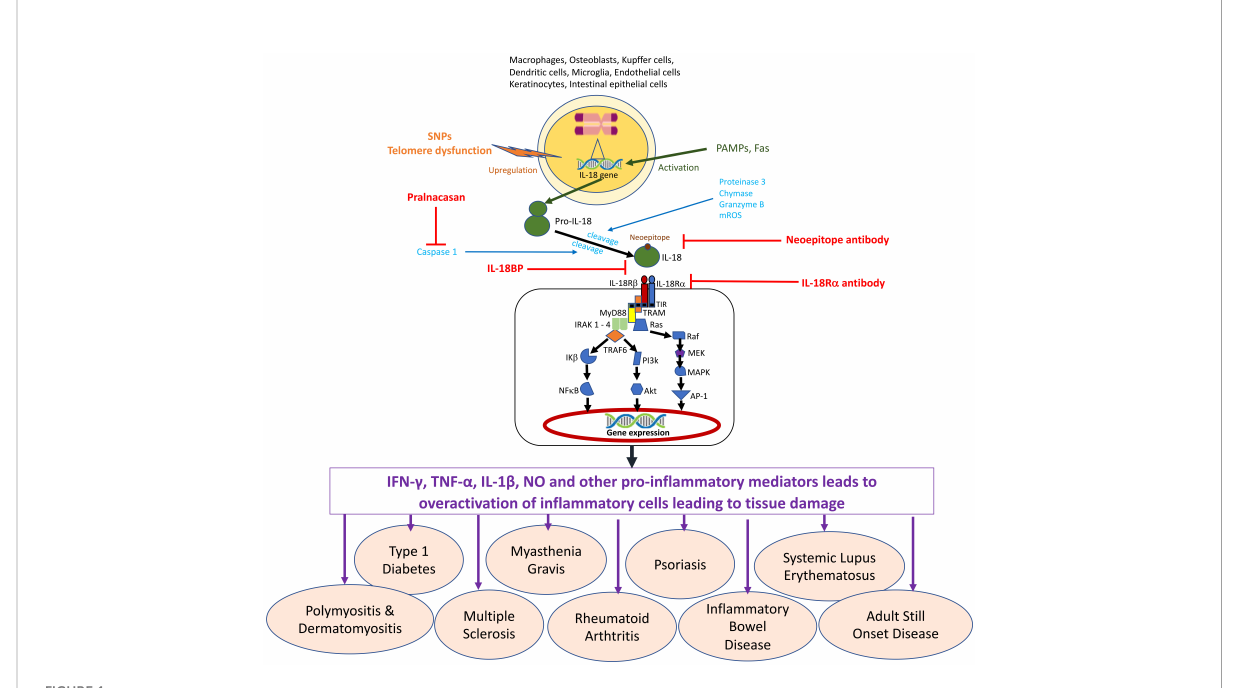
FIGURE 1 The cell sources and signaling mechanism for Interleukin